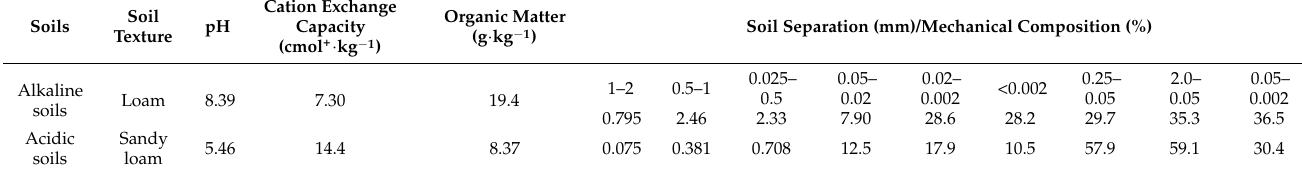
Table 1. Analytical data of